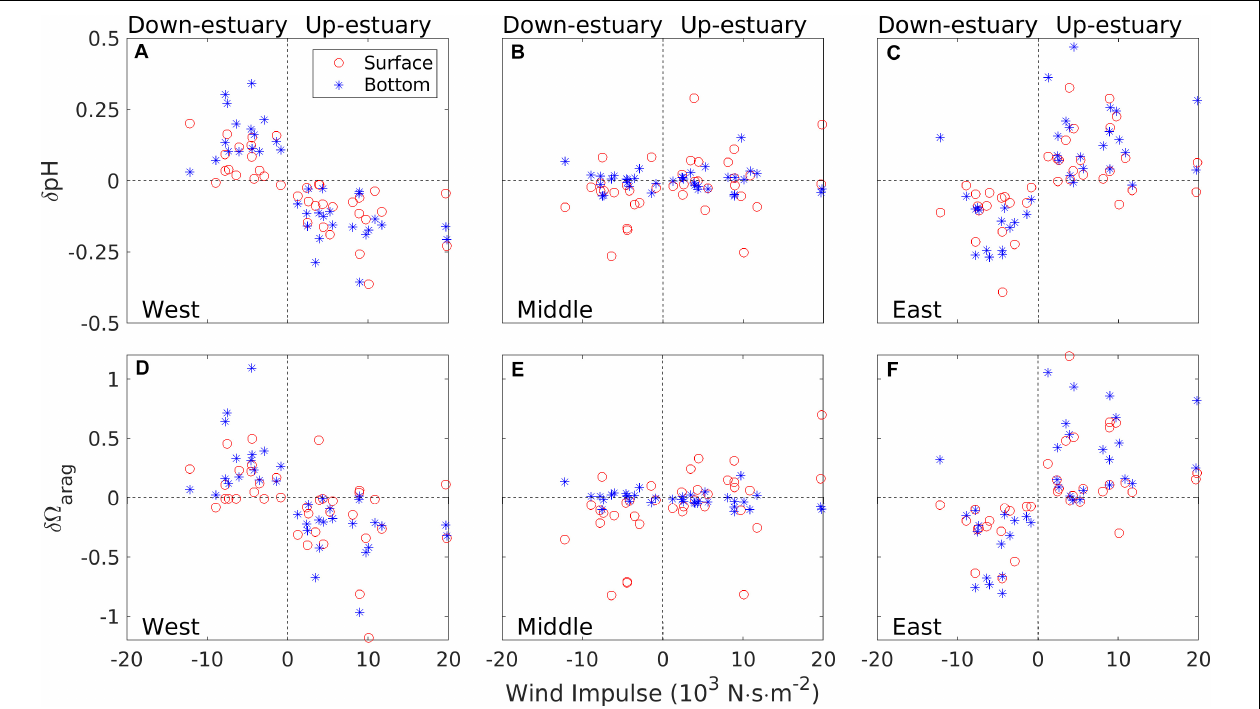
FIGURE 9 | Summary of wind effects on the temporal variations in pH/aragonite saturation state (cid:127) arag at the western shoal location (A,D) , the center channel (B,E) , and the eastern shoal location (C,F) : red open circles for surface pH/ (cid:127) arag and blue stars for bottom pH/ (cid:127) arag .